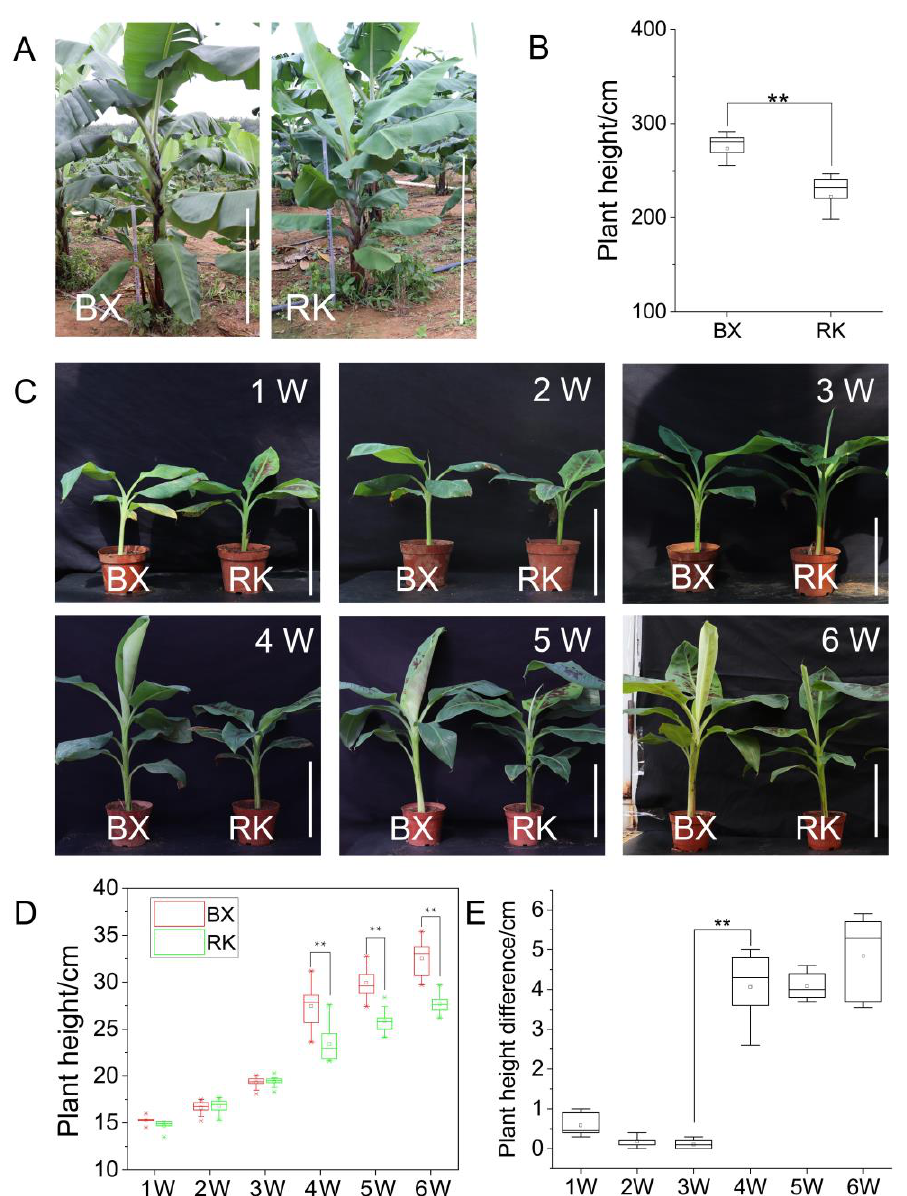
Figure 1. Changes in plant height during the growth between ‘BX’ and ‘RK’.( A ) Phenotypes o f ‘BX’ and ‘RK’ in the f ield. Bars = 1 m; ( B ) b ox plot of plant height in field of ‘BX’ and ‘RK’ (**, p ≤0.01) ; ( C ) g rowth changes of ‘BX’ and ‘RK’ from the first week to the sixth week in the greenhouse. Bars = 20 cm; ( D ) measurement of plant height betwe en ‘BX’ and ‘RK’ from th e first week to the sixth week in the greenhouse (**, p ≤ 0.01); ( E ) differences in plant height between ‘BX’ and ‘RK’ during the six weeks after planting.